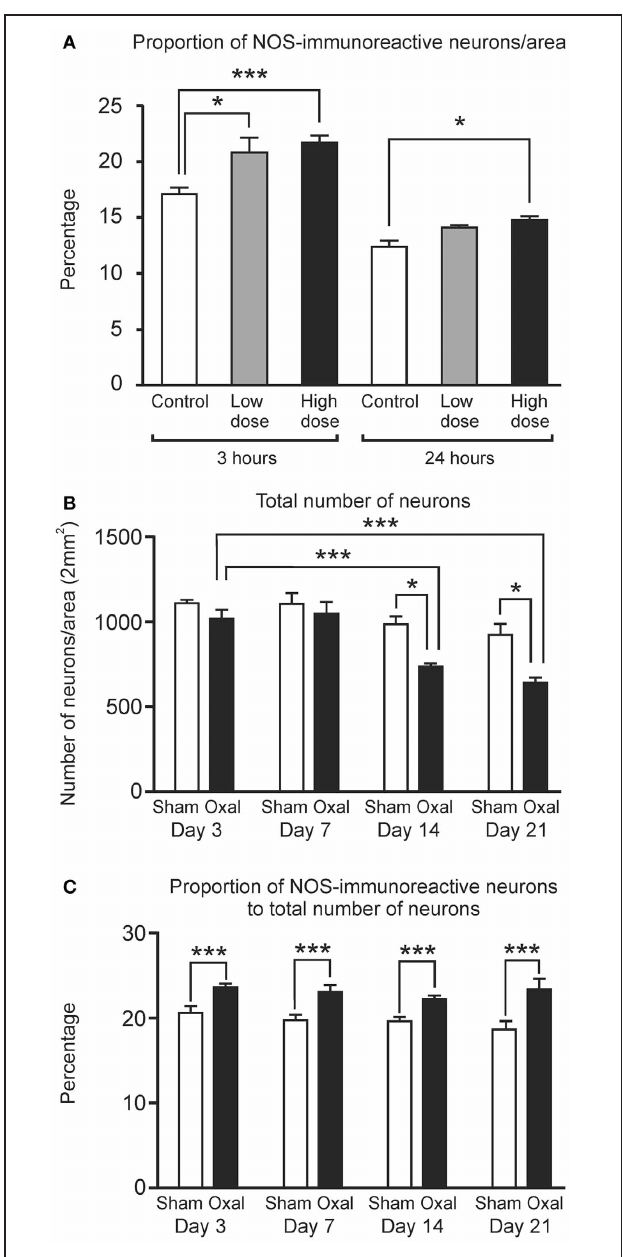
FIGURE 1 | In vitro and in vivo effects of oxaliplatin on the myenteric neurons in the mouse distal colon. (A) A significant increase in the proportion of NOS-IR neurons per area (2mm 2 ) within the myenteric plexus of the distal colon cultured with a high concentration of oxaliplatin compared to the control at both 3 ( ∗∗∗ P < 0 . 001) and 24h ( ∗ P < 0 . 05) and a low concentration of oxaliplatin at 3h of tissue culture ( ∗ P < 0 . 05). (B) A significant decrease in the total number of myenteric neurons at both Day 14 and Day 21 following in vivo oxaliplatin administration compared to the sham-treated at the same time points ( ∗ P < 0 . 05) and Day 3 oxaliplatin-treated mice ( ∗∗∗ P < 0 . 001). (C) Proportion of NOS-immunoreactive neurons per area (2mm 2 ) within the myenteric plexus of the distal colon was significantly increased at all four time-points (Days 3, 7, 14, and 21) following in vivo oxaliplatin administration compared to the sham-treated mice ( ∗∗∗ P < 0 . 001). All data represent the mean ±